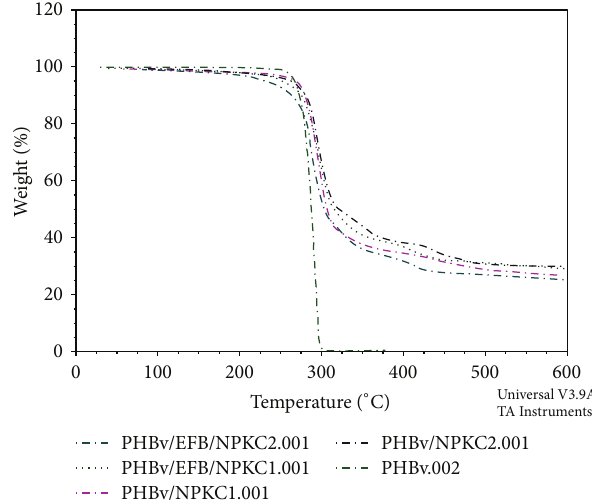
Figure 2: TGA thermograms showing the thermal properties of pure PHBv, PHBv/NPK, and PHBv/EFB/NPK composites. Note: PHBv (poly(hydroxybutyrate-co-valerate)), NPKC1 (uncoated) and NPKC2 (coated), and EFB (empty fruit